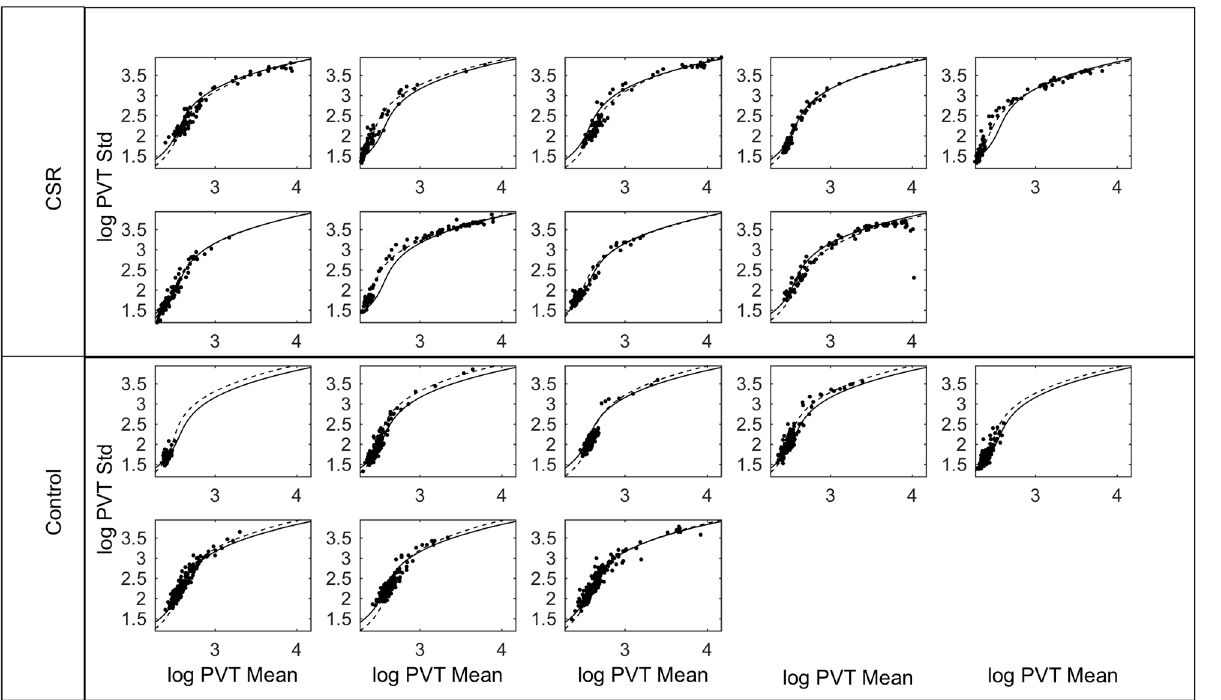
Fig 5. PVT standard deviation versus PVT mean for each participant. The same data as in Fig 4 are plotted separately for each participant. Polynomial fits are shown with fixed effects (solid black line) and with mixed effects (dashed line).